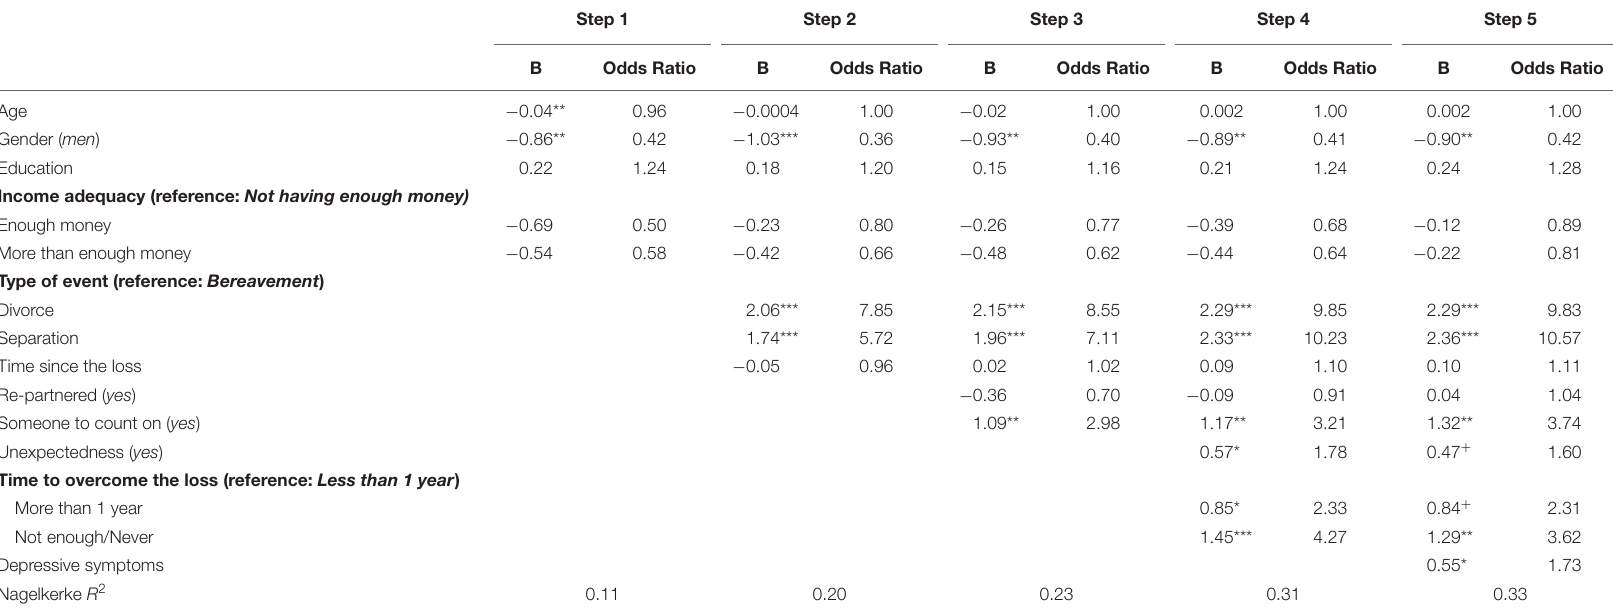
TABLE 3 | Person and event-related characteristics associated with PHS after partner loss ( N =